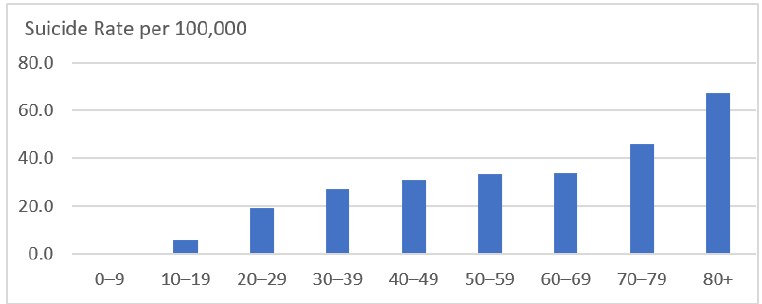
Figure 3. Suicide rate by age group (2019). Source: Statistics Korea [7].